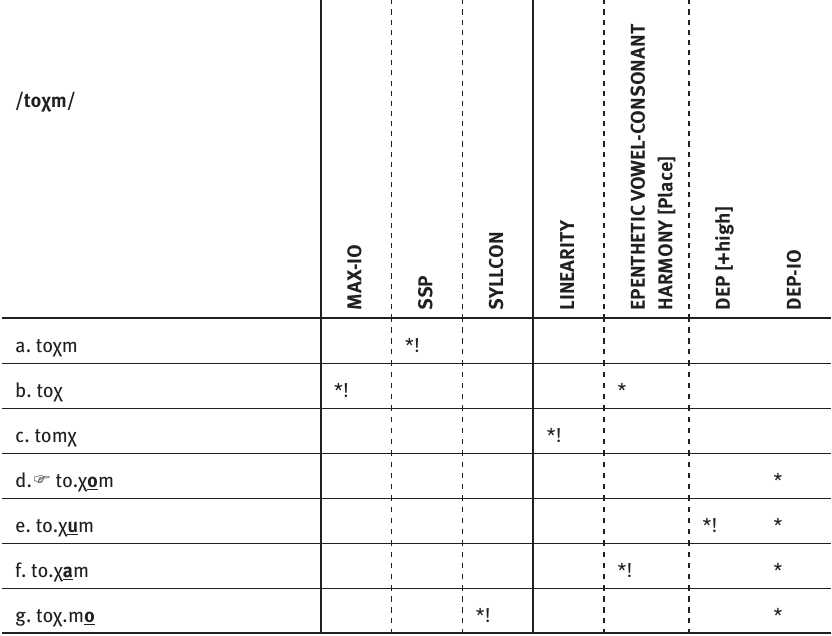
Table 9: MAX-IO, SSP, SYLLCON>>LINEARITY, EPENTHETIC VOWEL-CONSONANT HARMONY [Place], DEP [+high]>> DEP-IO